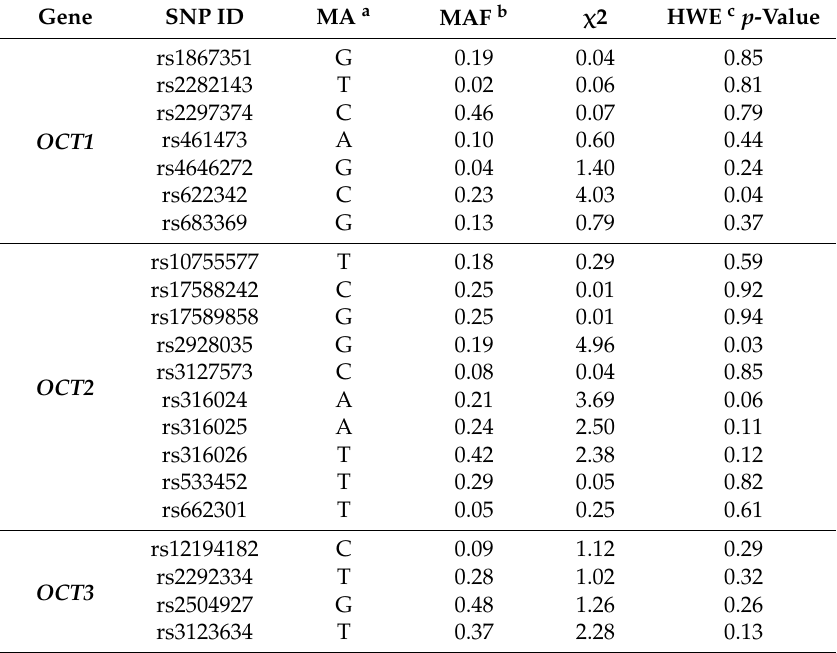
Minor allele frequencies among DM patients and the HWE p -value of candidate polymorphisms in OCT1 , OCT2 and OCT3